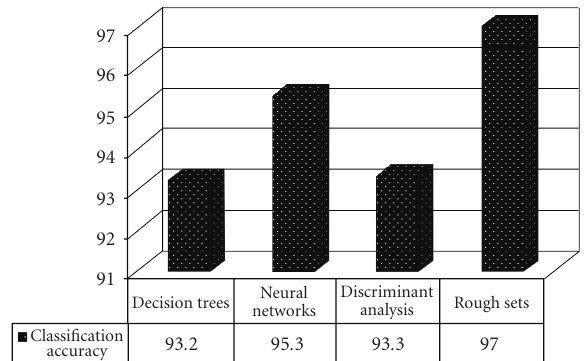
Figure 3: Compartive analysis in terms of the classification accu-